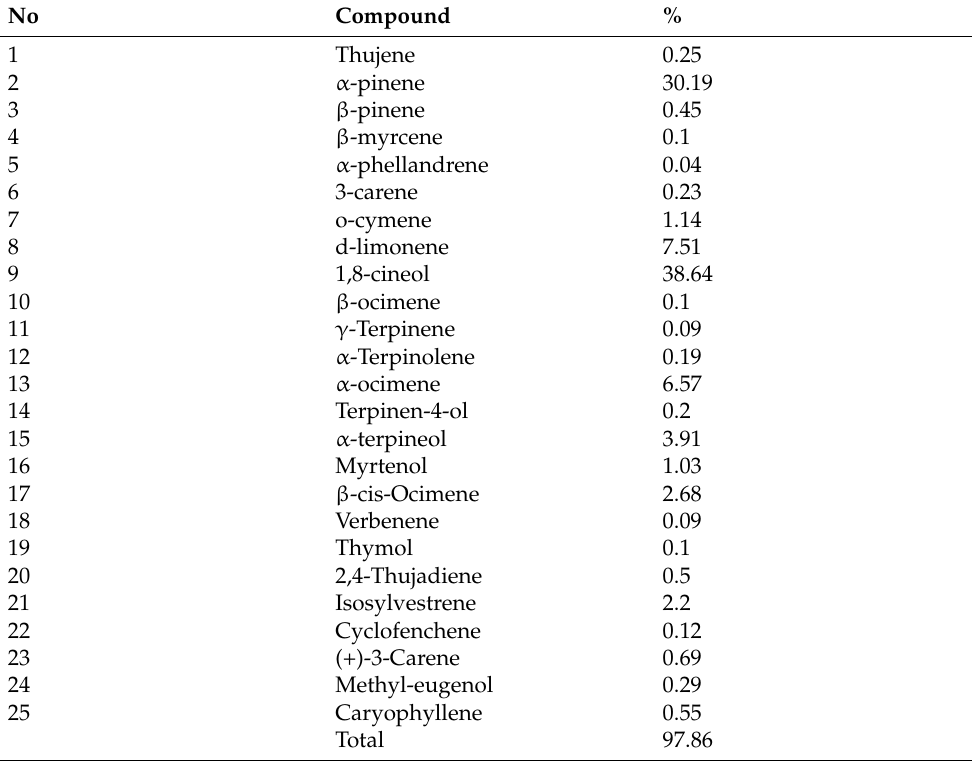
Table 1. Chemical composition of myrtle essential